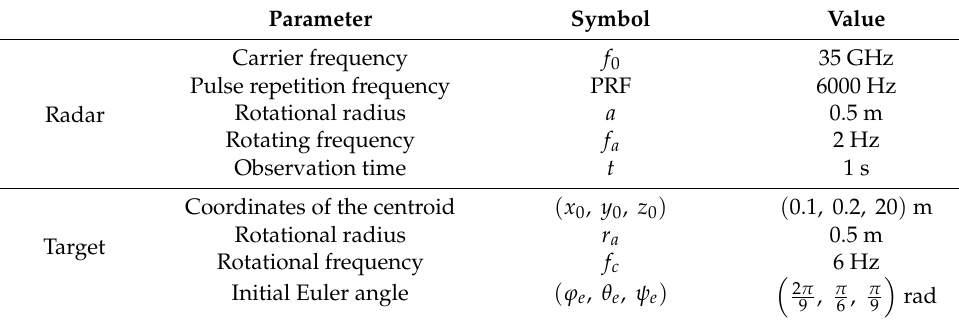
Table 1. Parameters of radar and spinning